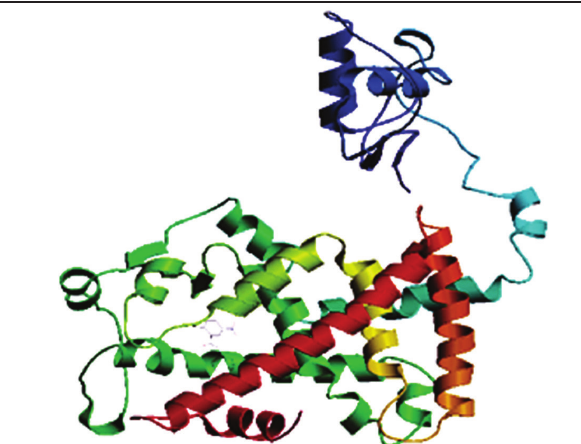
figurE 14 − Chimeric PAX8-PPARG